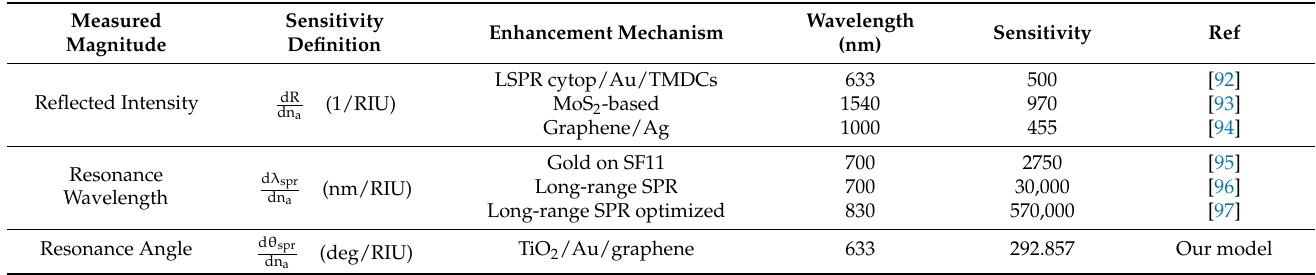
Table 8. Different existing measurement methods and sensitivity